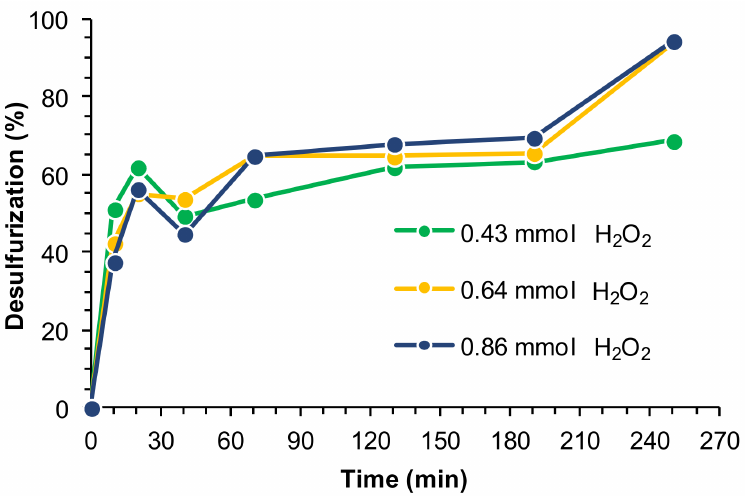
Figure 7. Desulfurization of a multicomponent model diesel (2000 ppm in sulfur) catalyzed by the UAV-59@PMMA membrane (containing 0.02 mmol Gd 3+ ), using different amounts of H 2 O 2 as oxidant (0.86, 0.64, and 0.43 mmol) and [BMIM]PF 6 as extraction solvent (1:1 diesel:solvent), at 70 ◦